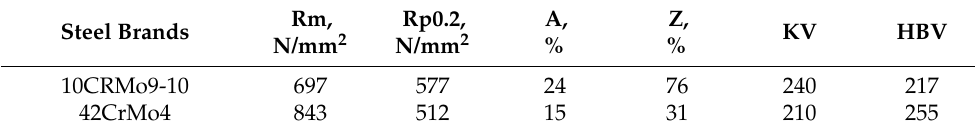
Table 13. The results were obtained under experimental